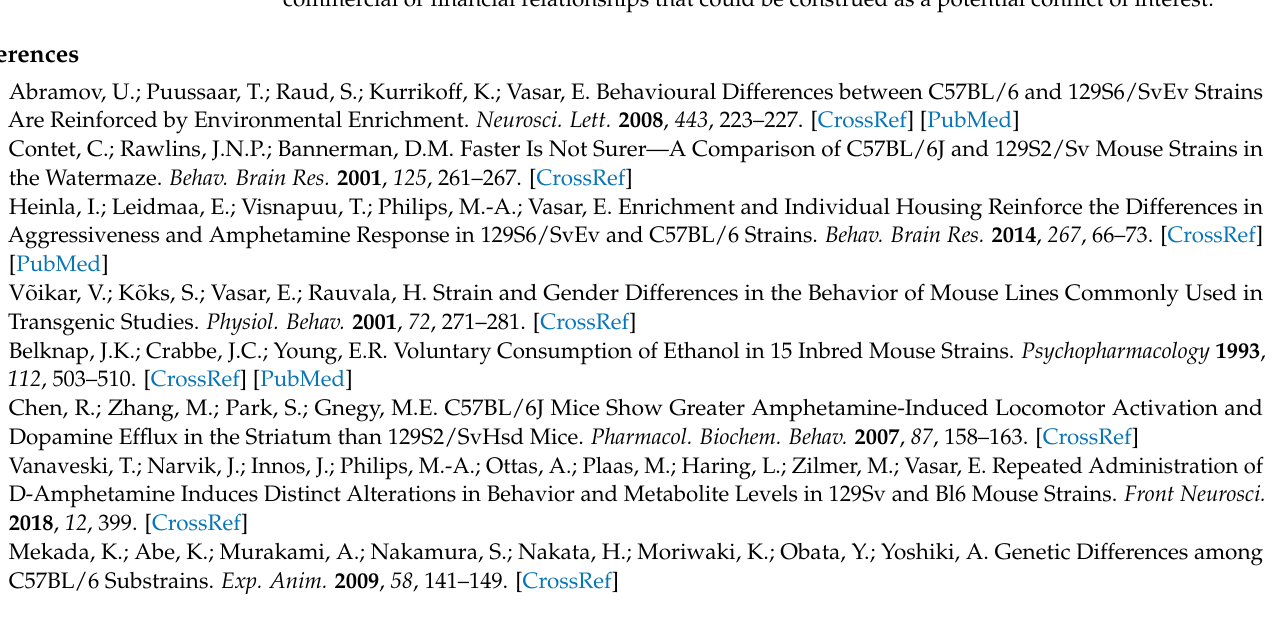
summary table of gene expression levels (log 2 values, mean and range) in Bl6 and 129Sv strain of HCC and RMT interventions, Table S2: Primers used for qPCR analysis, Table S3: Antibody list used for Western